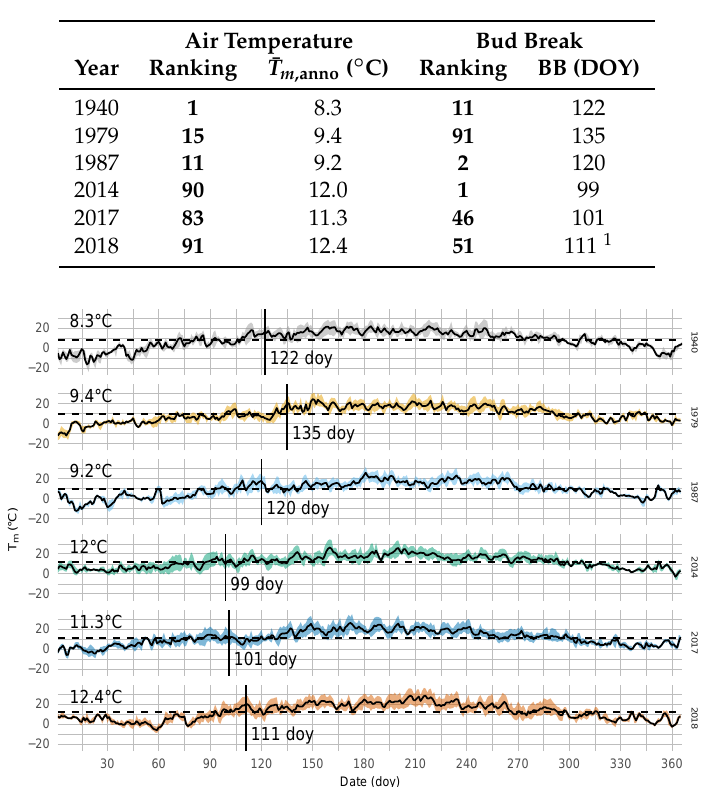
Figure 2. Annual cycle of mean air temperature ( T m ) for selected years (1940, 1979, 1987, 2014, 2017, and 2018) with their respective bud break date (vertical bar) and annual mean temperature ( T m ,anno ; dashed line). Ribbon range illustrates daily temperature range (min,